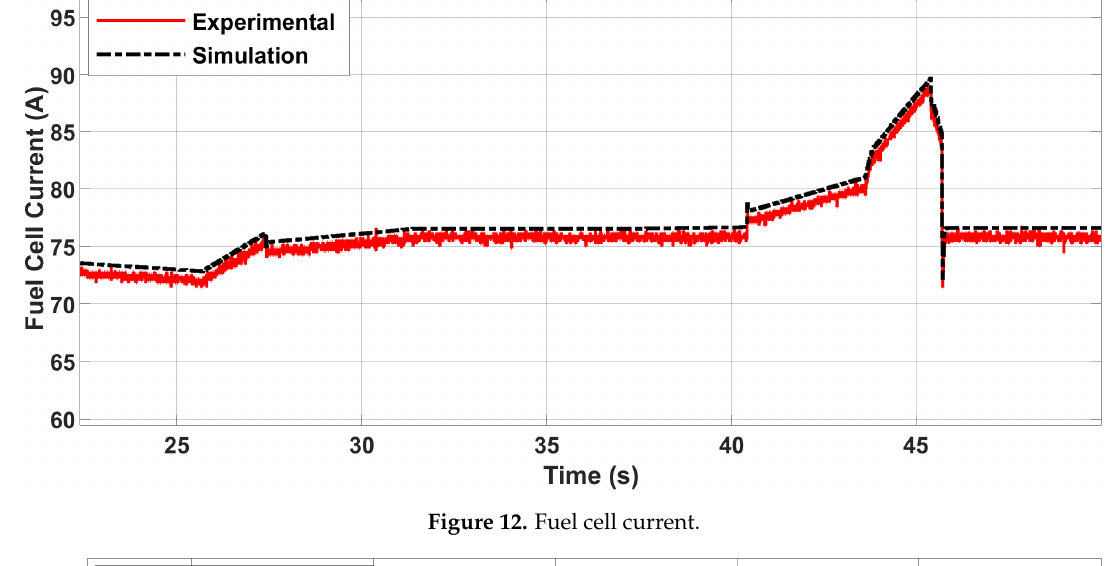
Figure 12. Fuel cell current.